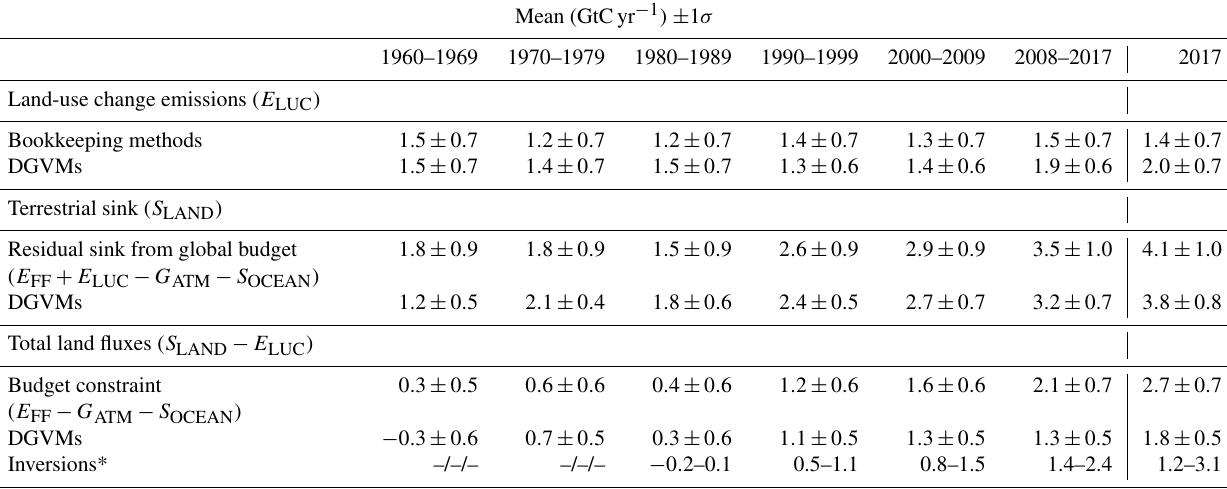
Table 5. Comparison of results from the bookkeeping method and budget residuals with results from the DGVMs and inverse estimates for different periods, the last decade, and the last year available. All values are in GtCyr − 1 . The DGVM uncertainties represent ± 1 σ of the decadal or annual (for 2017 only) estimates from the individual DGVMs: for the inverse models the range of available results is